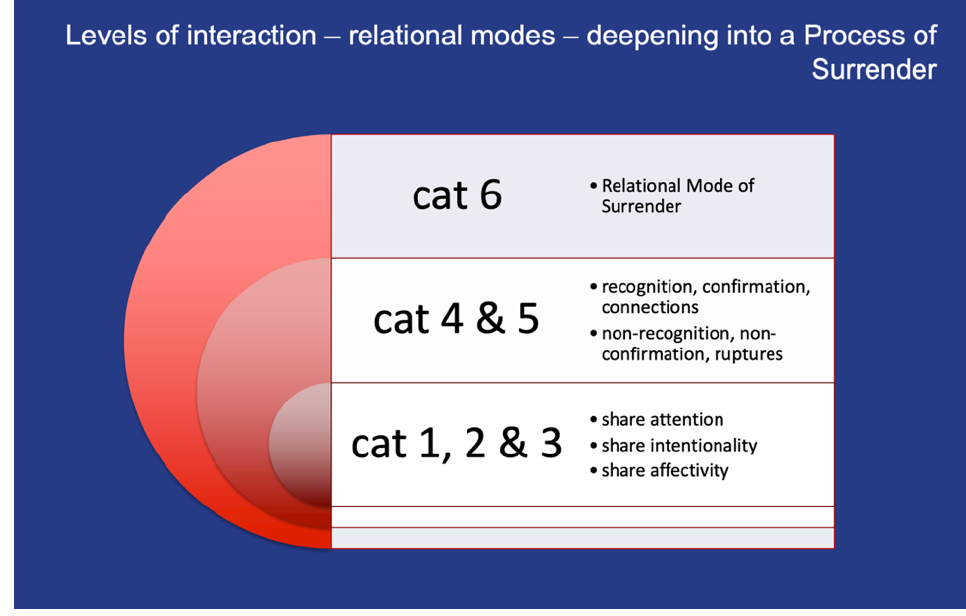
FFigigururee 77 Levels of Interaction Deepening into a Process of Surrender. Note:From Mårtenson Blom (2014, p. 146).